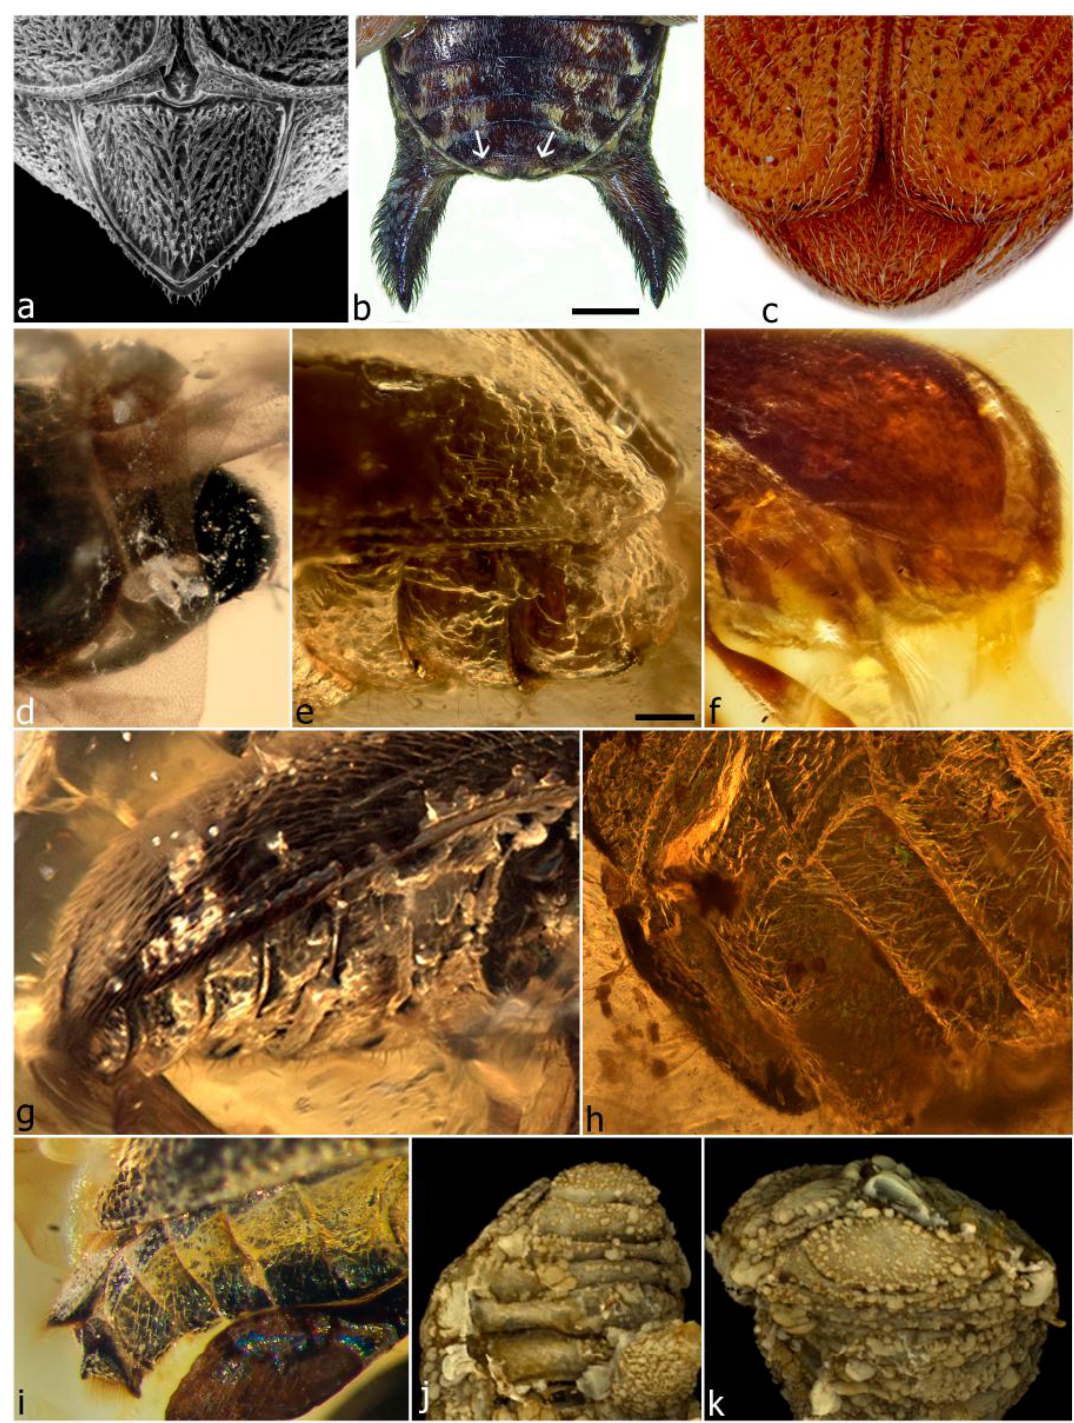
Figure 13. Pygidia and abdomens in extant and Burmese amber weevils. Araecerus fasciculatus , female (Anthribidae), caudal view ( a ); Telala sp. (Anthribidae), ventral view (arrows indicating long border with truncate ventrite 5) ( b ); Rhodocyrtus cribripennis (Attelabidae), caudal view ( c ); Acalyptopygus brevicornis (Mesophyletidae), dorsal view ( d ); A. lingziae , lateral view ( e ); Burmonyx zigrasi (Nemonychidae), caudolateral view ( f ); Acalyptopygus astriatus (Mesophyletidae), ventrolateral view ( g ); Echogomphus viridescens (Mesophyletidae), ventral view ( h ); Bowangius tanaops (Mesophyletidae), right lateral view ( i ); Calyptocis brevirostris (Mesophyletidae), ventral view ( j ); same, caudal view ( k ). Scale bars: 1.0 mm (b); 0.1 mm (e).